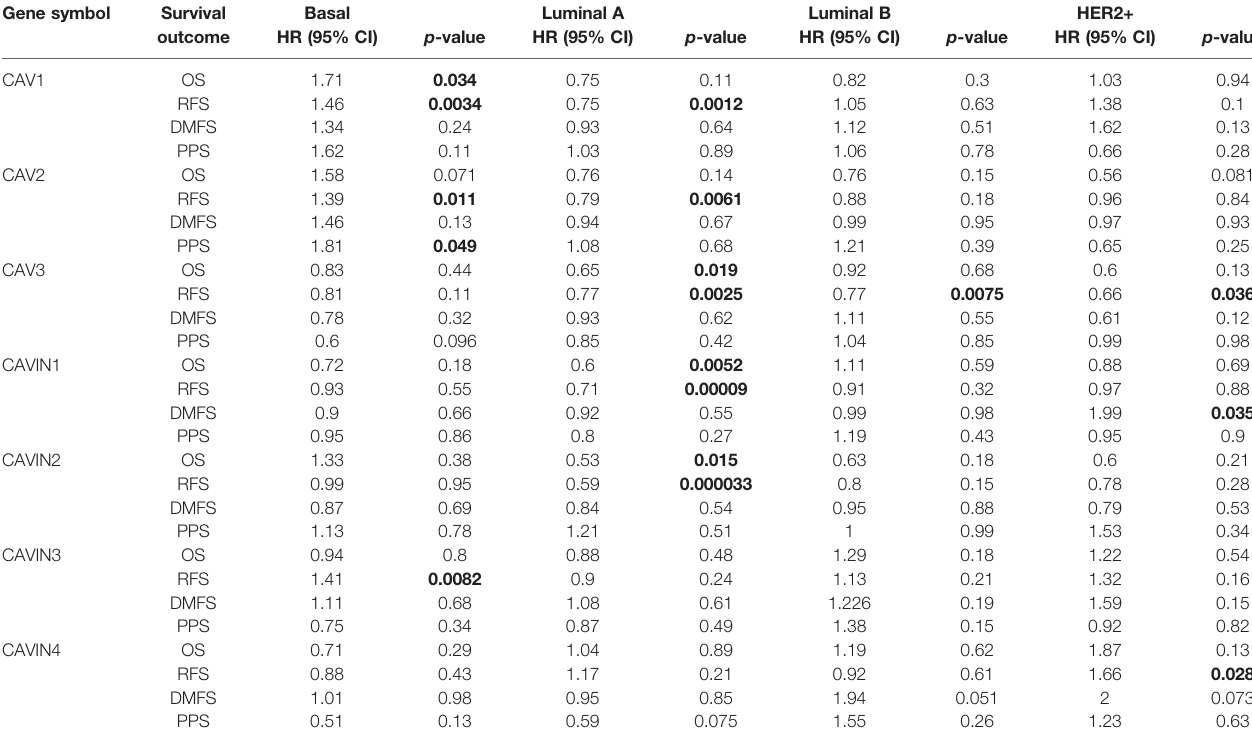
TABLE 3 | Correlation of CAVs/CAVINs transcription levels and survivals of patients with different molecular subtypes of breast cancer. Gene symbol Survival outcome